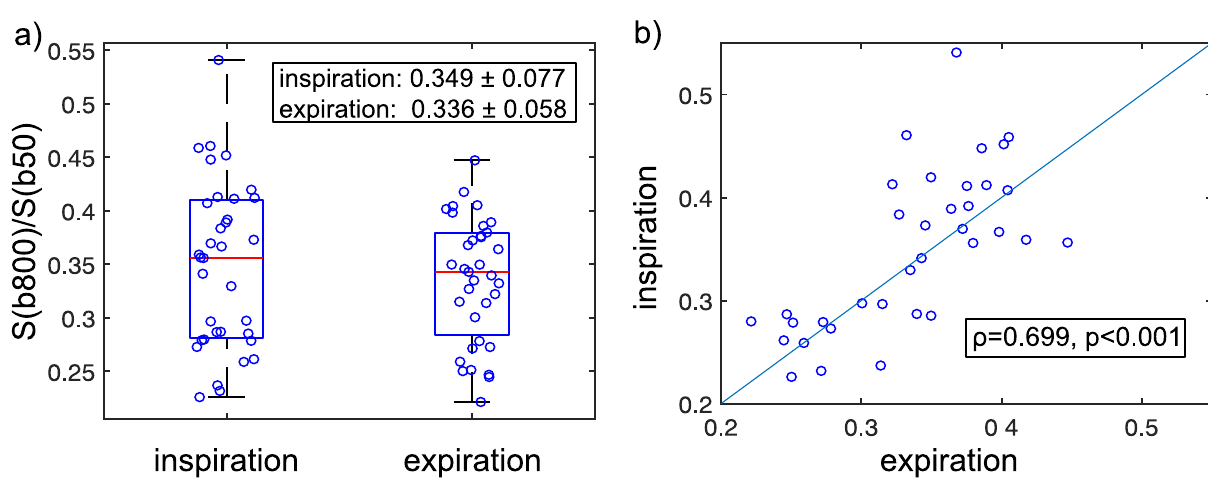
Fig 5. Normalized signal intensities measured in the left liver lobe in inspiration and expiration. S(b800) is the signal measured at b = 800 s/mm 2 and S(b50) is the signal measured at b = 50 s/mm 2 . Each marker represents one patient. a) Boxplots. b) Scatter-plot of the same data shown in (a). The Spearman rank correlation coefficient is